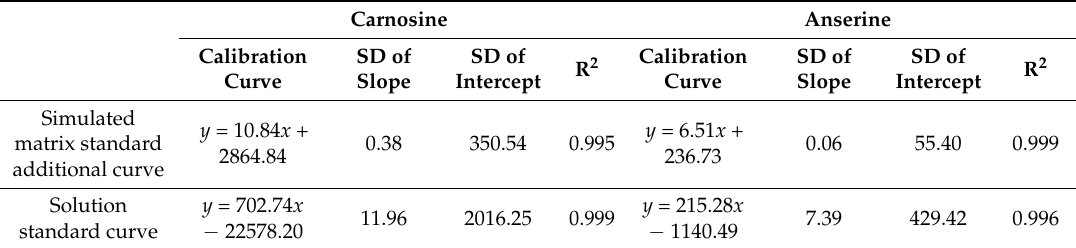
Table 2. Calibration curves of quantitative determination of carnosine and anserine in meat and bone meal